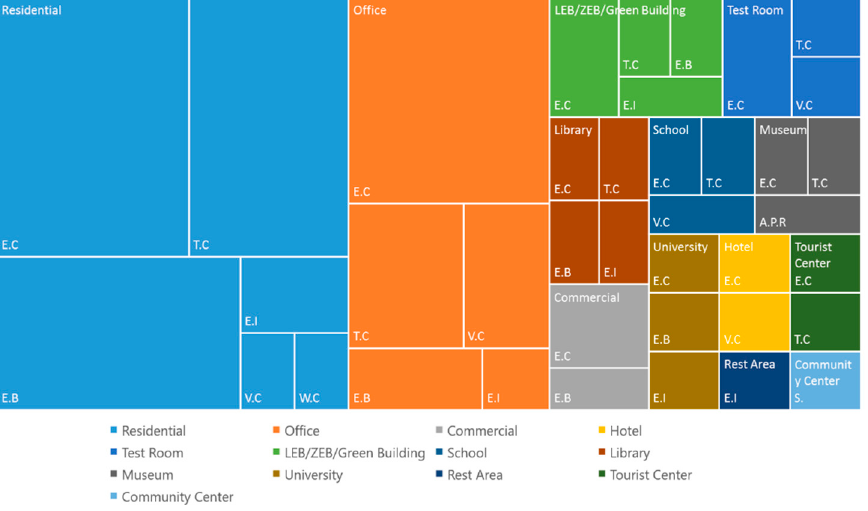
Figure 12. The frequency of the objective functions from different aspects for various applications in the tree map